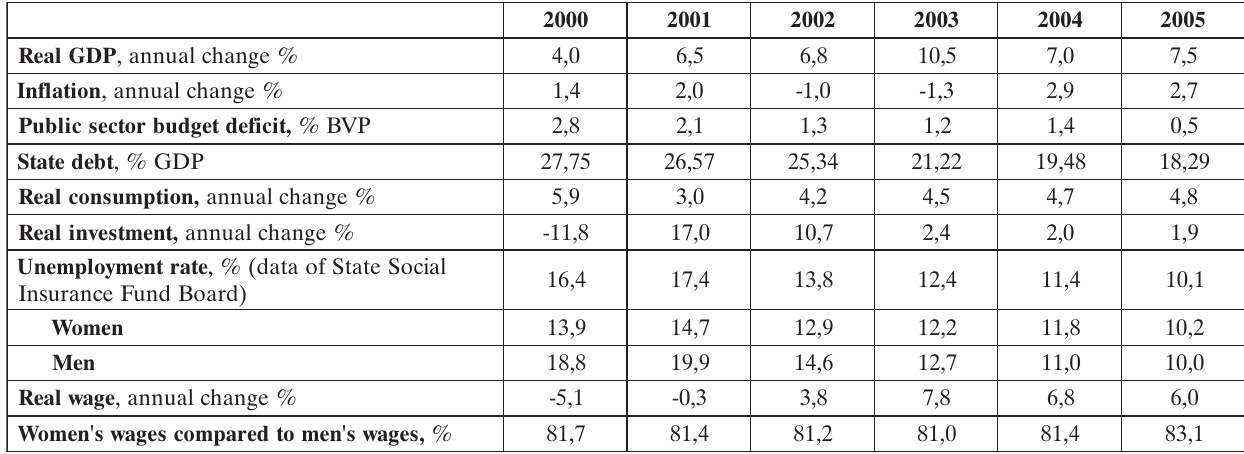
Table 1. Lithuania’s macroeconomic and social indicators for